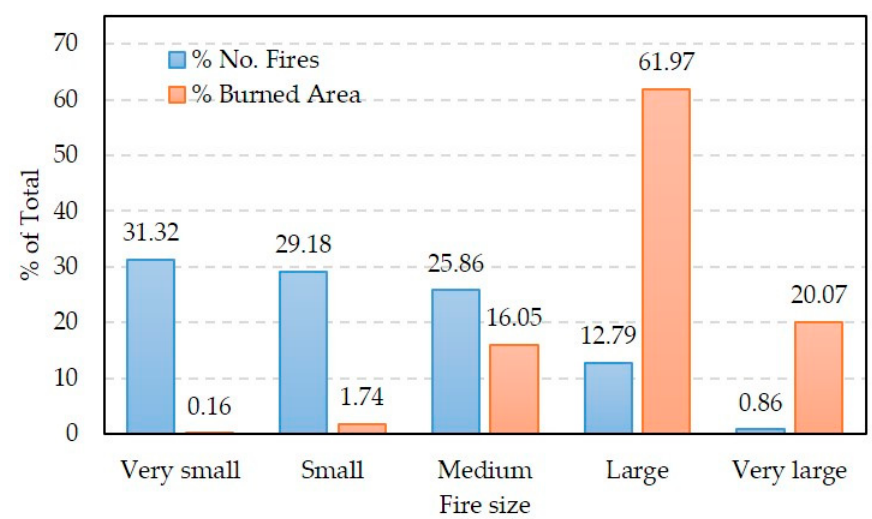
Figure 3. Percentage of the total number of recorded fires by the Alaska Fire Service (AFS) and total area burned according to the five categories considered for the sizes of the fires in Figure 2 for the 18 years of study (2000–2017).